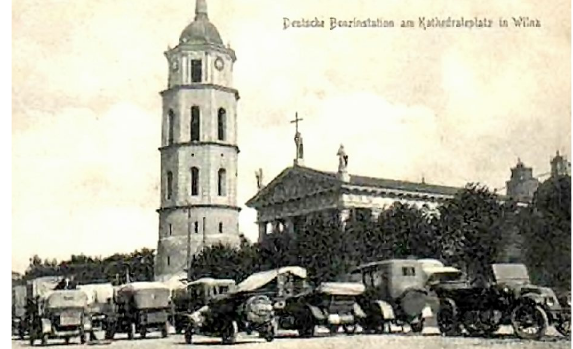
Fig. 7. Cars at the petrol station at the Cathedral